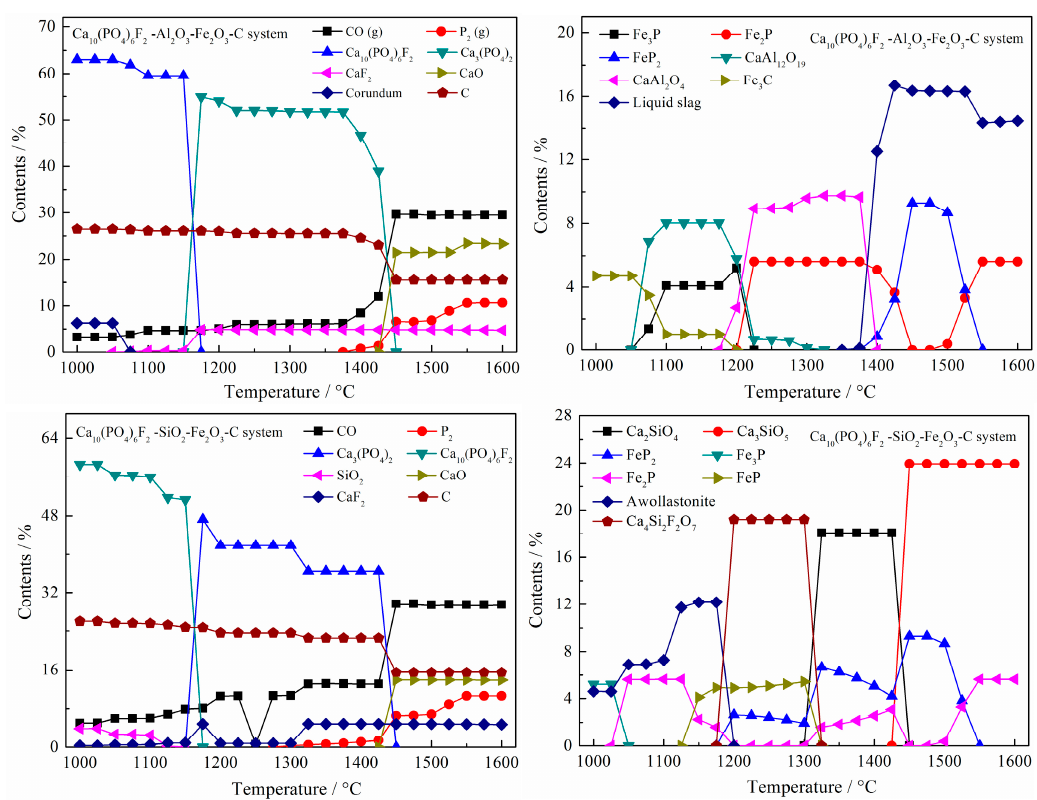
Figure 2. Relationship between equilibrium composition (wt.%) and temperature of the system of